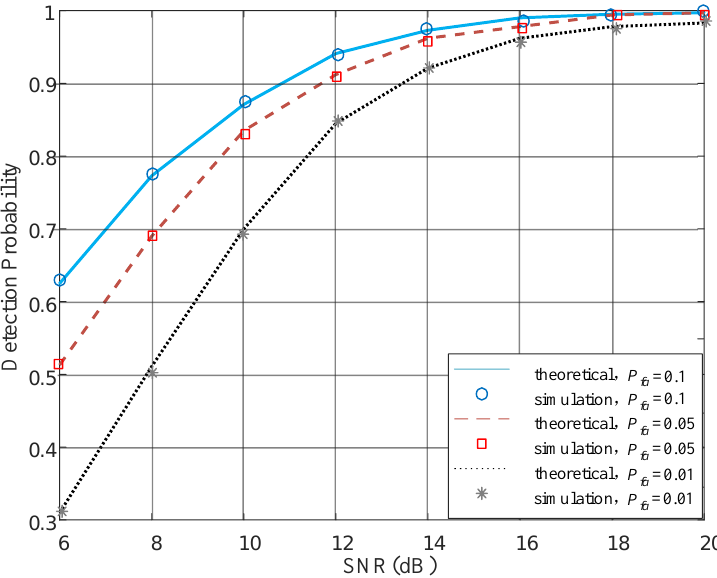
Figure 3. Theoretical expression for false alarm rate (FAR) and miss detection rate (MDR) validation.